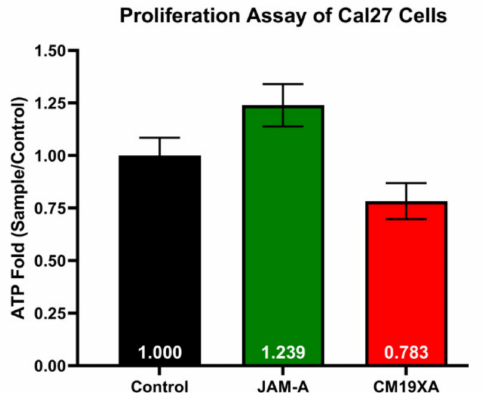
Figure 2. CM19XA decreases Cal27 cell proliferation. Data are expressed as fold of CAL27 prolif- eration without treatment (control). JAM-A compared to the control increases proliferation, while CM19XA caused a decrease in proliferation compared to the control and JAM-A. This decrease in proliferation is due to the pHLIP portion of CM19XA inserting itself into the membrane, allowing for the JAM-A portion to bind to other JAM proteins in trans. As a result, the binding of JAM-A of CM19XA in trans allows for an increase in cell-to-cell interaction. Statistical analysis using Student’s t -test was